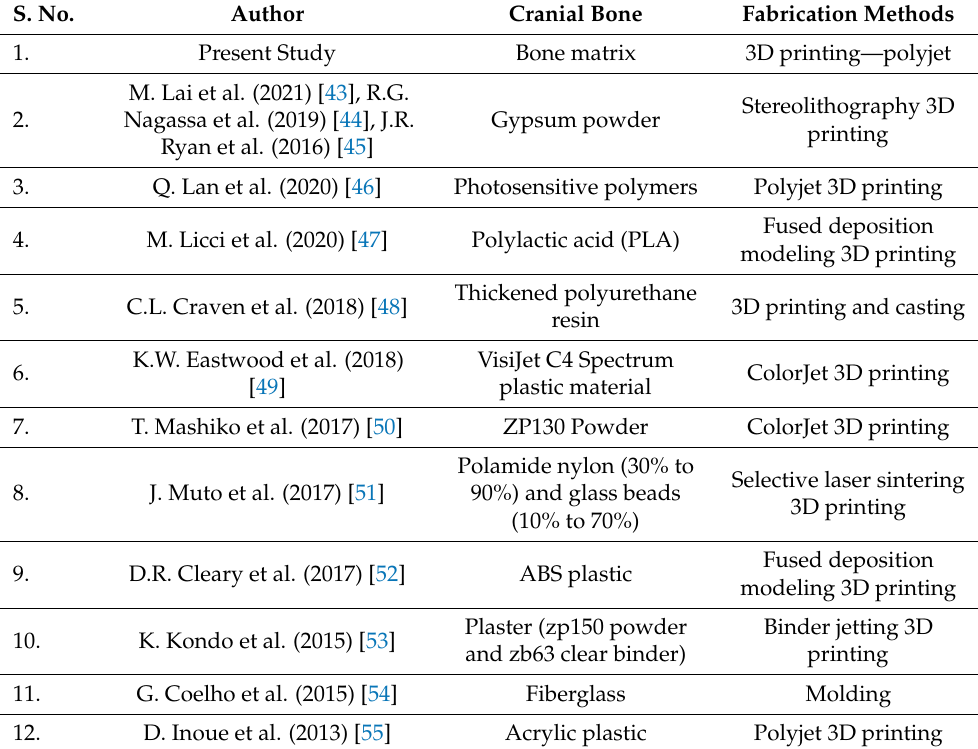
Table 3. Materials used for fabrication of cranial bones for surgical